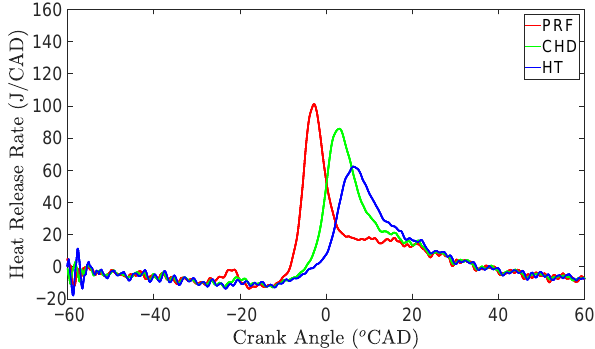
Figure 8. Heat release rate for the three fuels with T inlet 90 ◦ C.